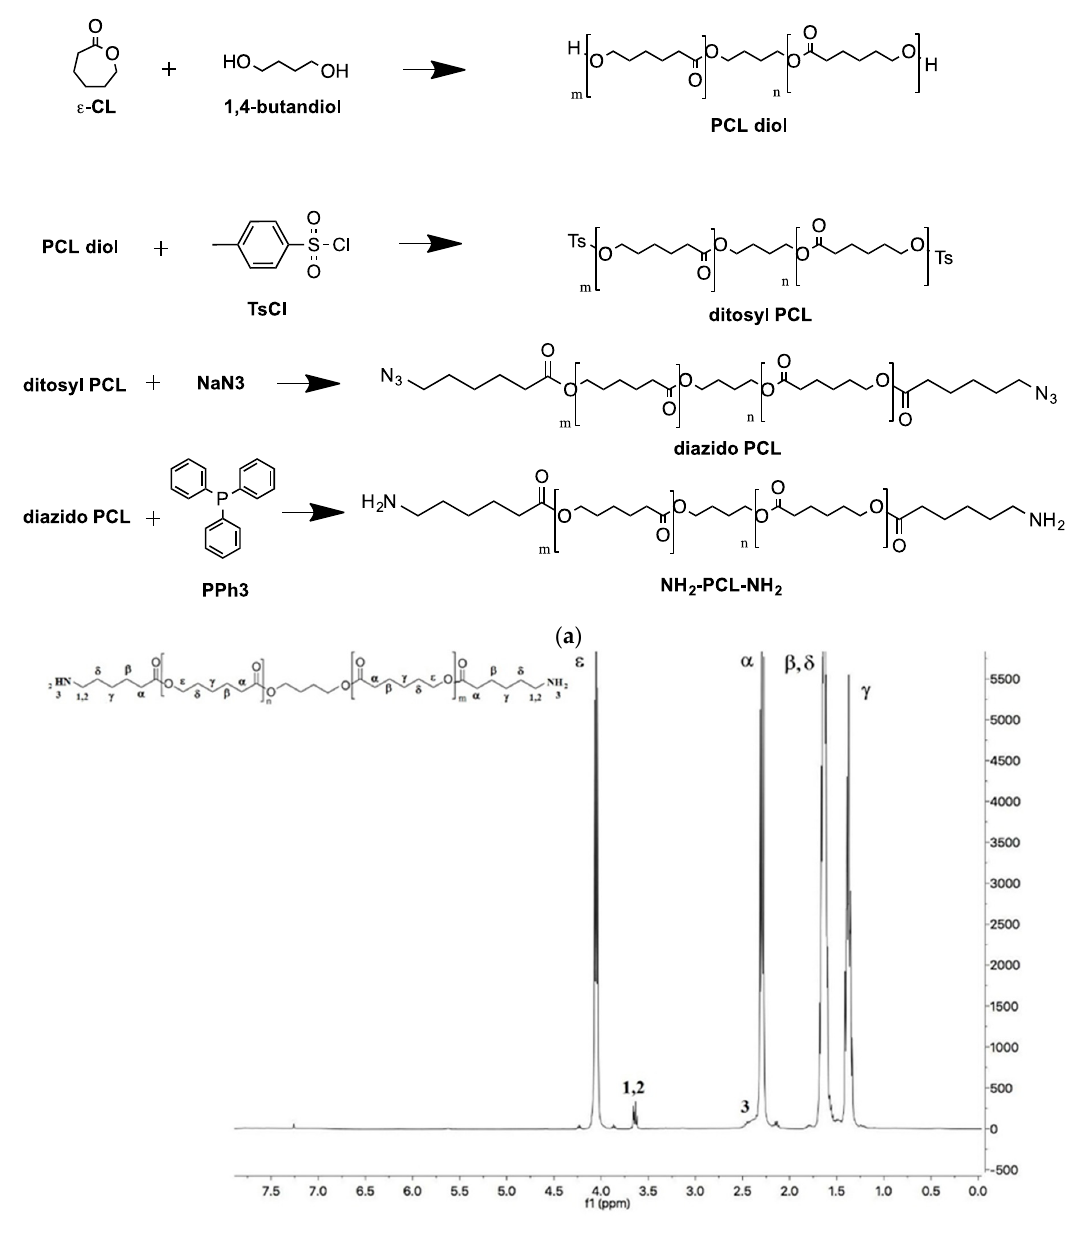
Figure 1. ( a ) Steps for the synthesis of NH 2 -PCL-NH 2 . ( b ) 1 H NMR spectrum of NH 2 -PCL-NH 2 in CDCl 3 .